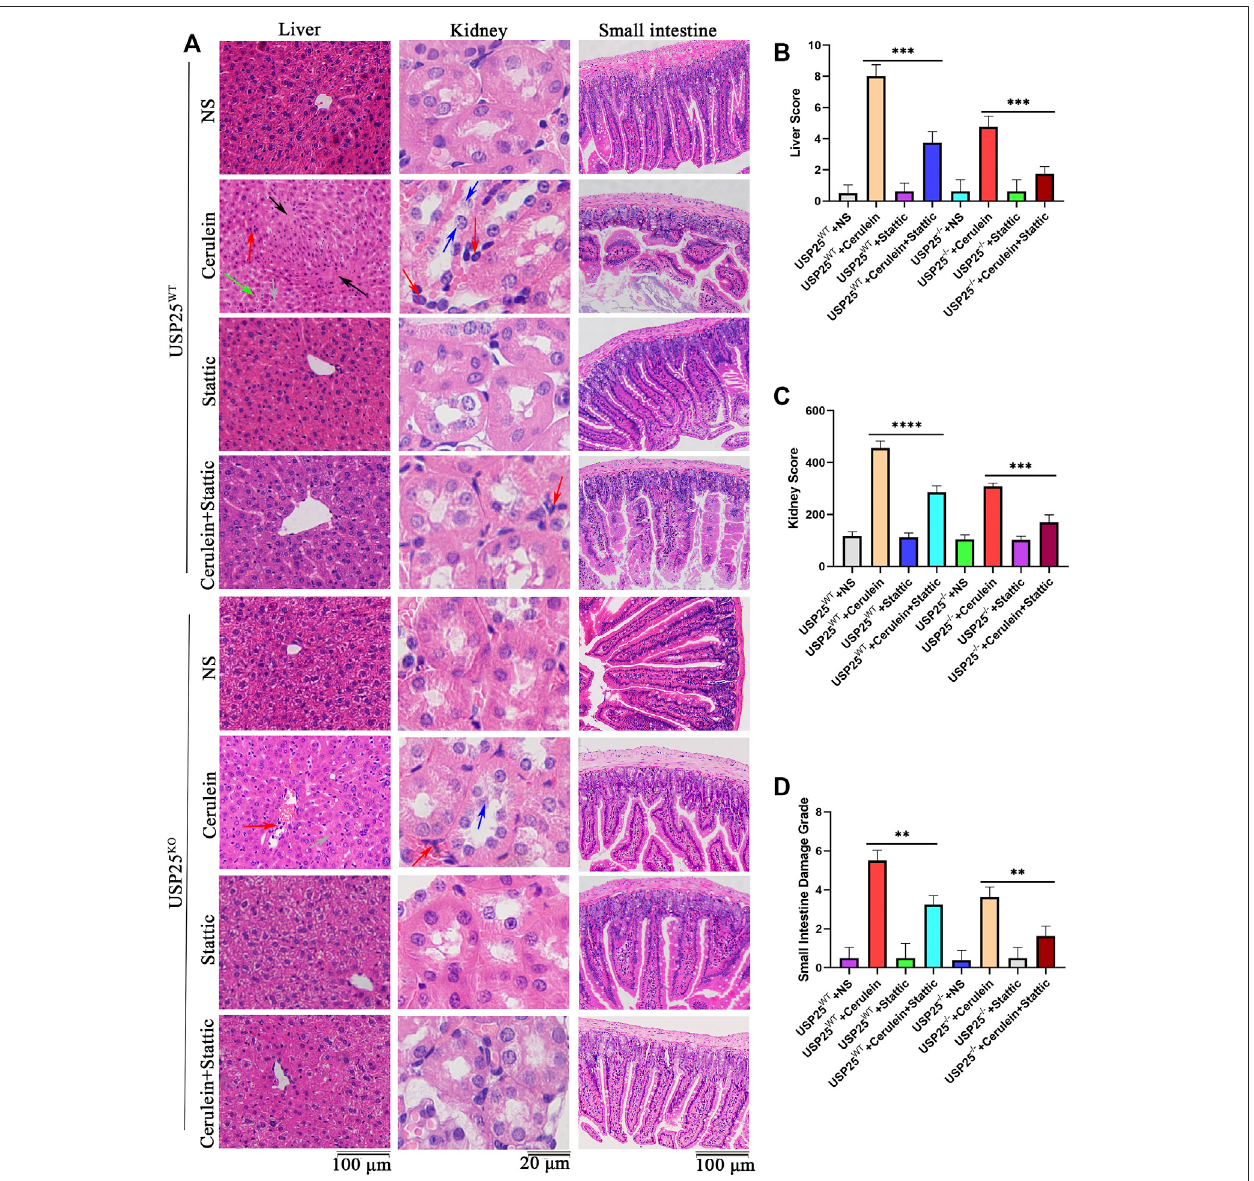
FIGURE 7 | USP25 aggravates acute pancreatitis-related liver, kidney, and small intestine injury through activating STAT3 pathway in vivo . Stattic was used to interferewithSTAT3phosphorylationinUSP25 WT andUSP25 − / − mice,thenceruleinwasusedtoinduceAPinmice. (A) H&Estainingofliver,kidneyandsmallintestinein eight experimental groups (Black arrow: necrosis; red arrow: in fl ammatory cell; green arrow: cytoplasmic vacuolation; grey arrow: edema; blue arrow: detachment of tubular epithelial cell). (B – D) The histological scores of liver, kidney and small intestine in eight experimental groups. **P < 0.01, ***p < 0.001 and ****p < 0.0001.